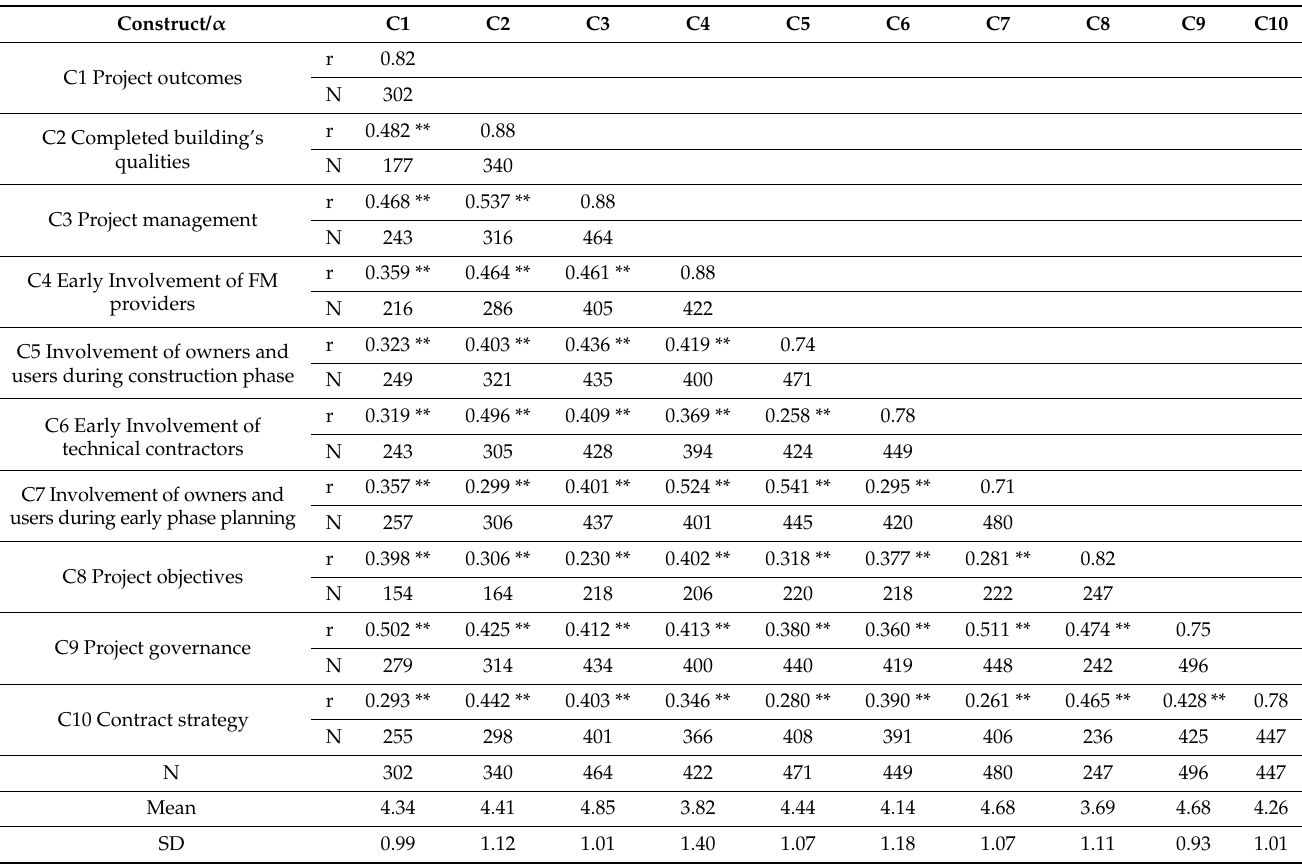
Table 6. The constructs’ correlation